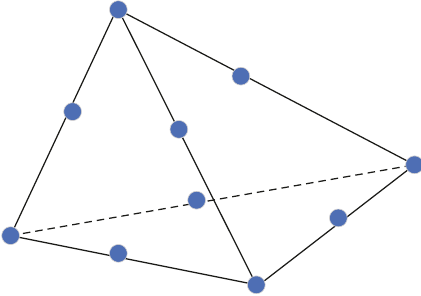
Figure 3: The ten-node tetrahedral